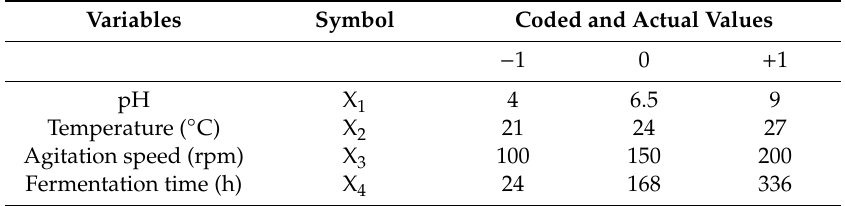
Table 1. Coded and actual values of the variables for the four factor Box–Behnken experimental design. Variables Symbol Coded and Actual Values −